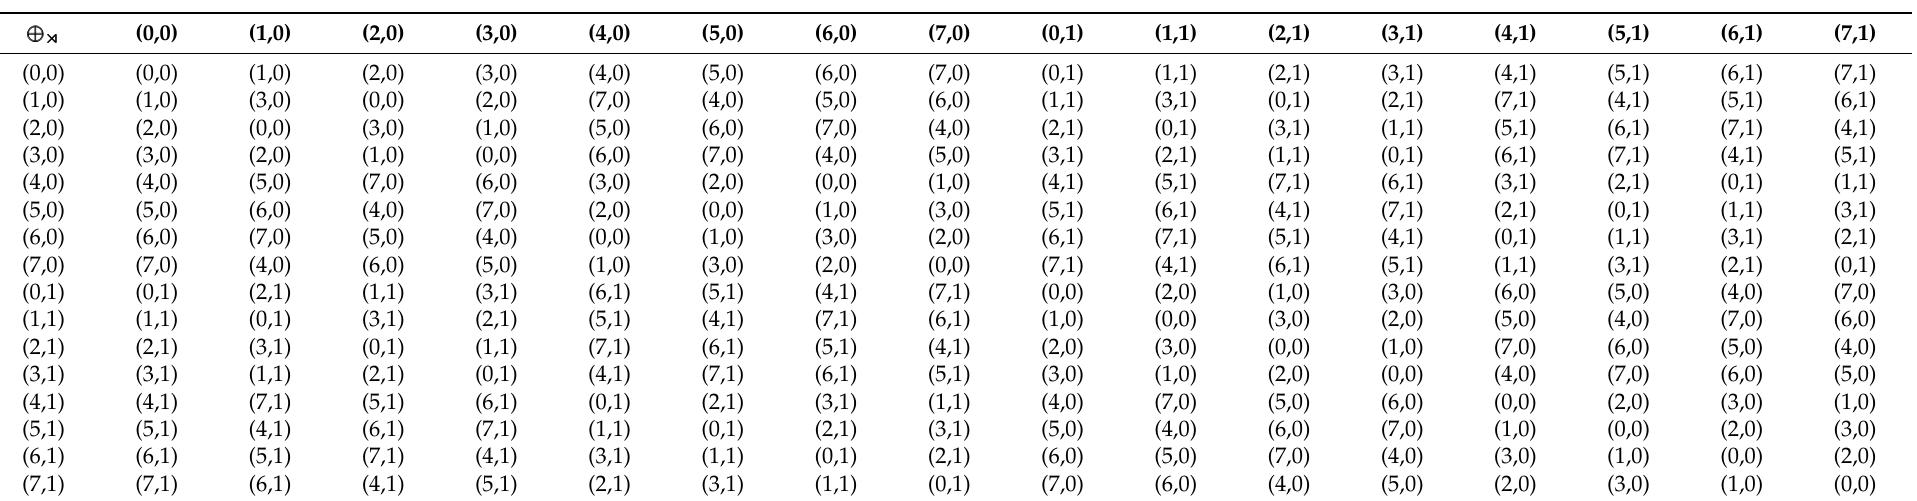
Table 2. The gyroaddition table of the gyrogroup Dih ( G 8 )